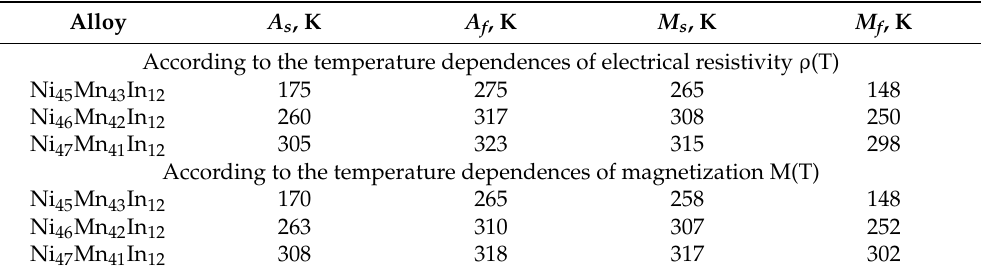
Table 3. Phase transition temperatures for the Ni 47 − x Mn 41+x In 12 (x = 0; 1; 2) alloys. The temperatures at the beginning and end of austenitic ( A s , A f ) and martensitic ( M s , M f ) transformation, respectively. Alloy A s , K A f , K M s , K M f , K According to the temperature dependences of electrical resistivity ρ (T) Ni 45 Mn 43 In 12 175 275 265 148 Ni 46 Mn 42 In 12 260 317 308 250 Ni 47 Mn 41 In 12 305 323 315 298